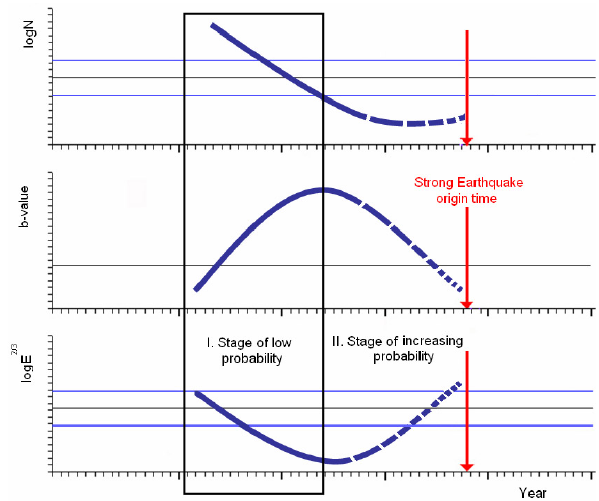
Figure 1. Characteristic FastBEE output schematic general trend of the temporal prognostic anomaly (solid blue lines) before a strong earthquake occurrence. The open rectangular parallelogram denotes the first low probability stage, since the prognostic anomaly begin- ning, followed by a second higher probability stage, which con- cludes with the strong earthquake occurrence. Vertical red arrow shows the earthquake origin time from Baskoutas and Popandopou- los